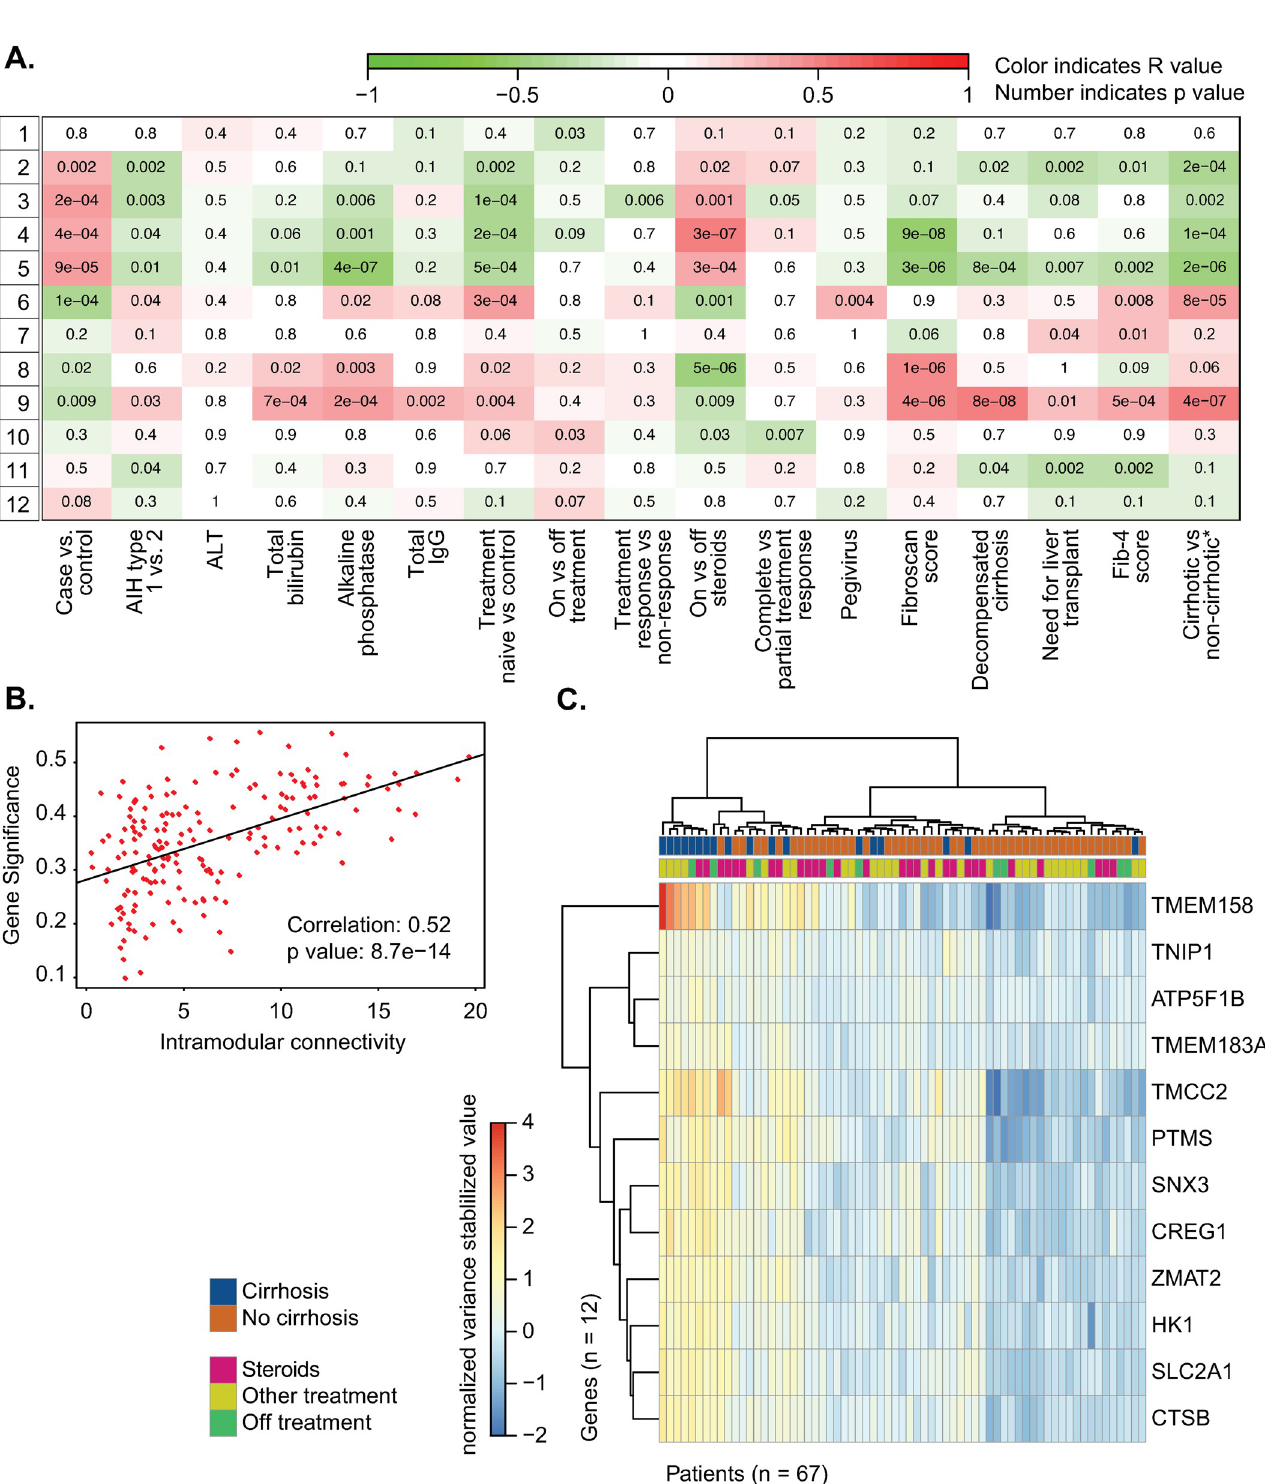
Fig 3. A. WGCNA module trait graph, with patient metadata on the x-axis and generated gene modules on the y-axis. B. Interconnectivity plot for gene module 9 identified by WGCNA. C. Heatmap displaying gene counts (variance stabilizing transformation, see DESeq2) of the top 12 hub genes identified from interconnectivity metrics as described in Methods. Samples are clustered on the x-axis using a Ward D2 method and color annotated with cirrhosis status and treatment at sample collection.